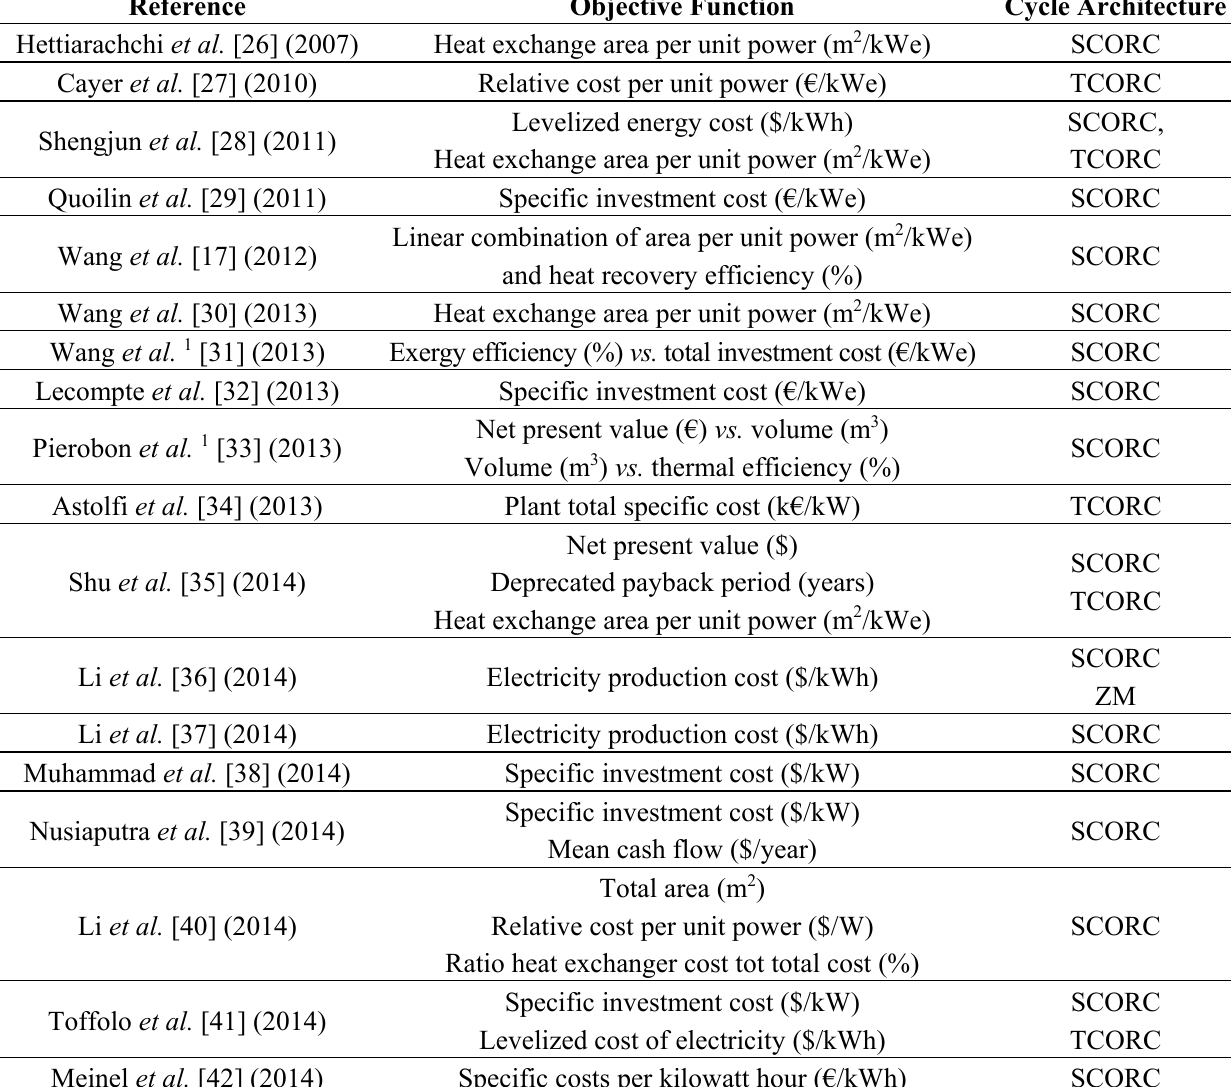
Table 1. Scientific papers on thermo-economic optimization of